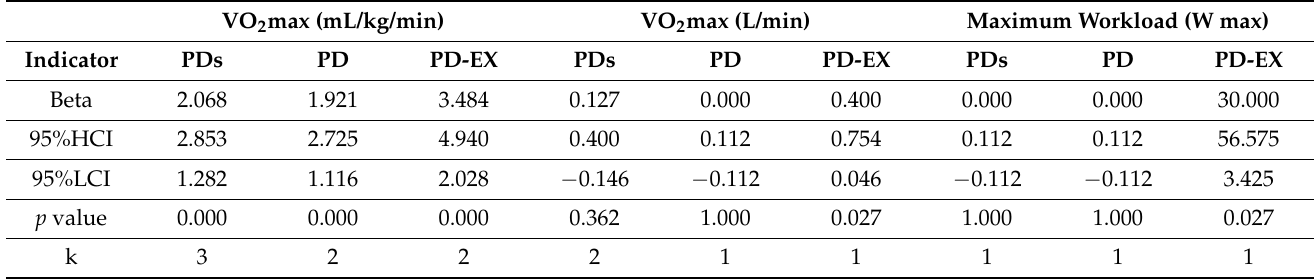
Table 10. Changes in physical capacity (VO 2 max; Maximum Workload) in PD, PDs, and